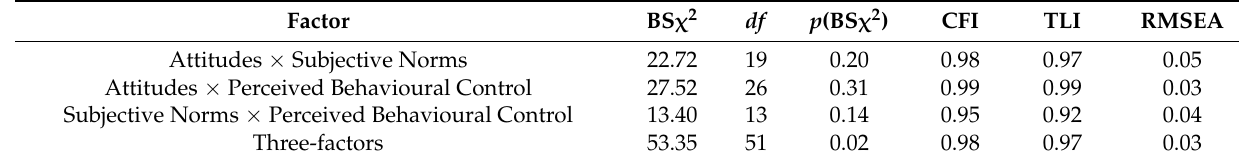
Table 7. Descriptive statistics, measure error variances, factor loadings and composite reliabilities for the beliefs about green exercise (BAGE). Refinement Group ( n = 253) Validation Group ( n = 230) Factor Loadings Factor Loadings Items Var(e) Var(e) ATT SUB PBC ATT SUB PBC